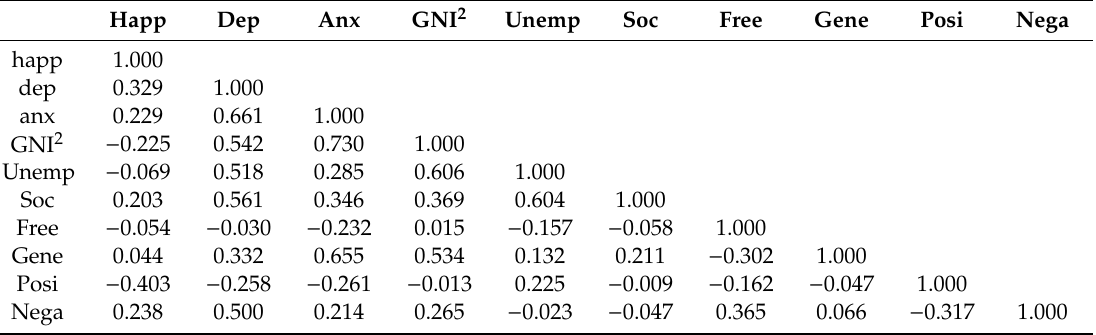
Table A4. The correlation matrix among variables in low-income